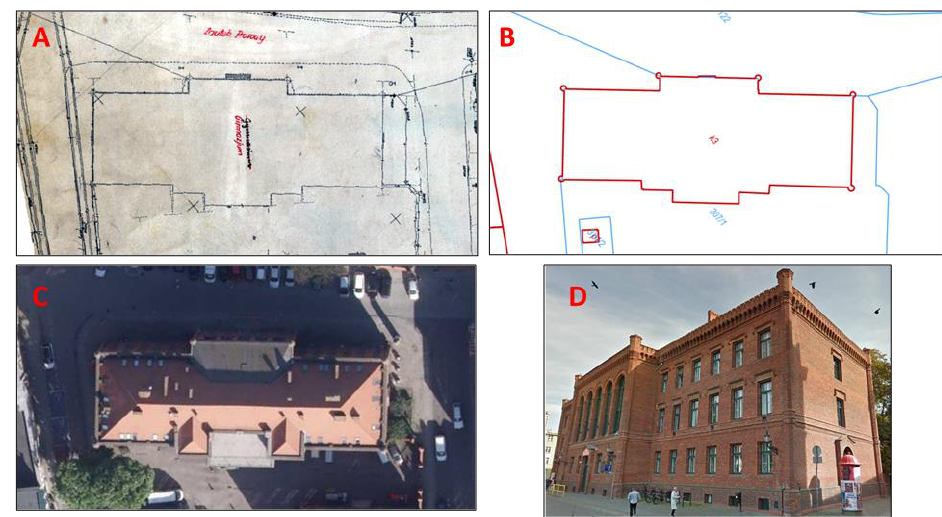
Figure 6. A comparison of the image of a building, as seen on ( A ) the cadastral map, ( B ) Registry of lands and buildings, ( C ) orthophoto map and ( D ) on Google Street View. Source: own work based on GUGiK (Head Office of Geodesy and Cartography) data (national geoportal), Google Street View service and Gemarkungskarte der Stadt Thorn, Blatt 46, State Archives in Toruń.